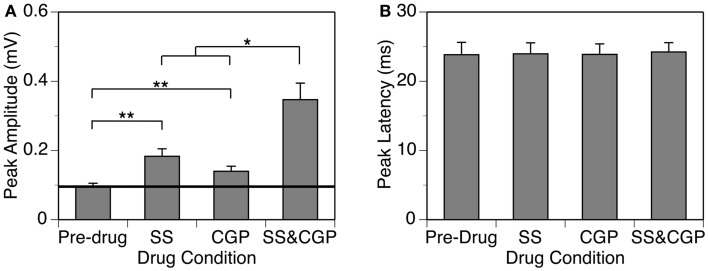
Group results (n = 8) obtained at 10 dB above the MT showing effects of individual applications of SS and CGP35348 (two middle bars) and a simultaneous application of the drugs (right bar) on the peak amplitude (A) and latency (B) of the DN. A horizontal line in (A) represent the mean peak amplitude of the DN obtained before drug application. Double stars indicate statistical significance at the level of p < 0.005. A single star indicates statistical significance at a level of p < 0.05. Error bars represent SE.